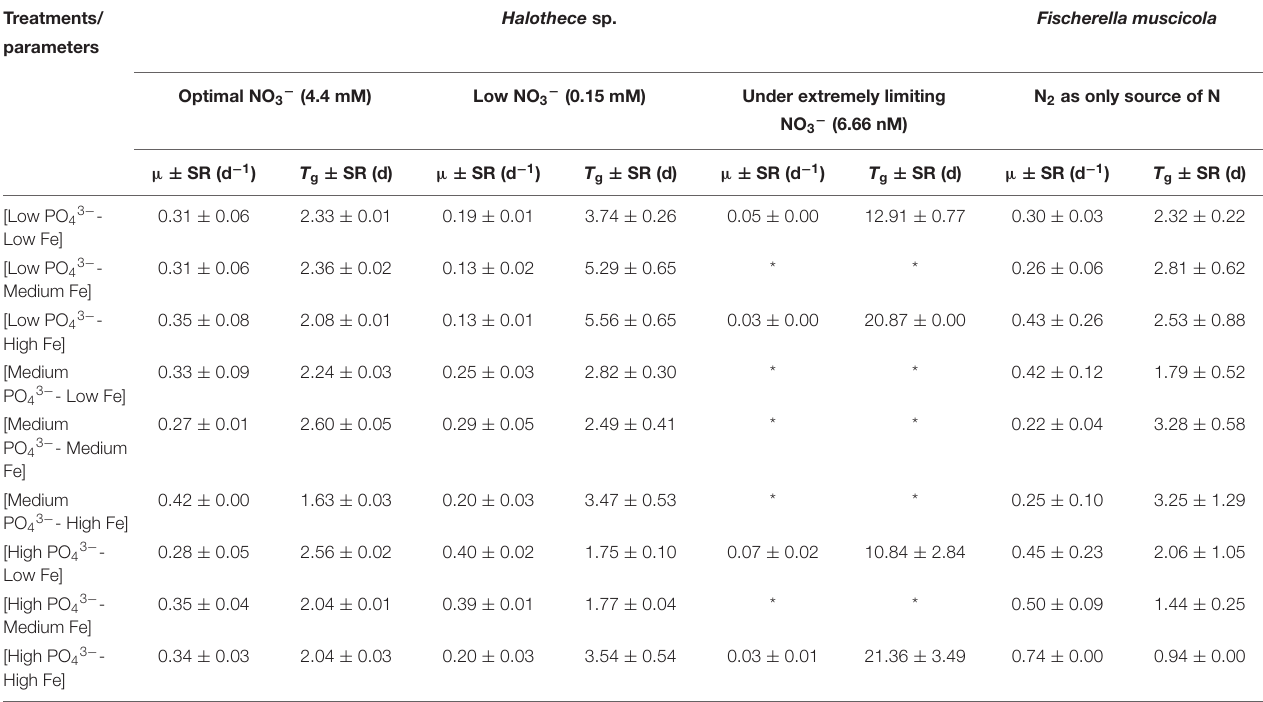
TABLE 1 | Growth rate ( µ ) and generation time ( T g ) for Halothece sp. (at different NO 3 − concentrations) and Fischerella muscicola at different combinations of PO 43 − and Fe concentrations.